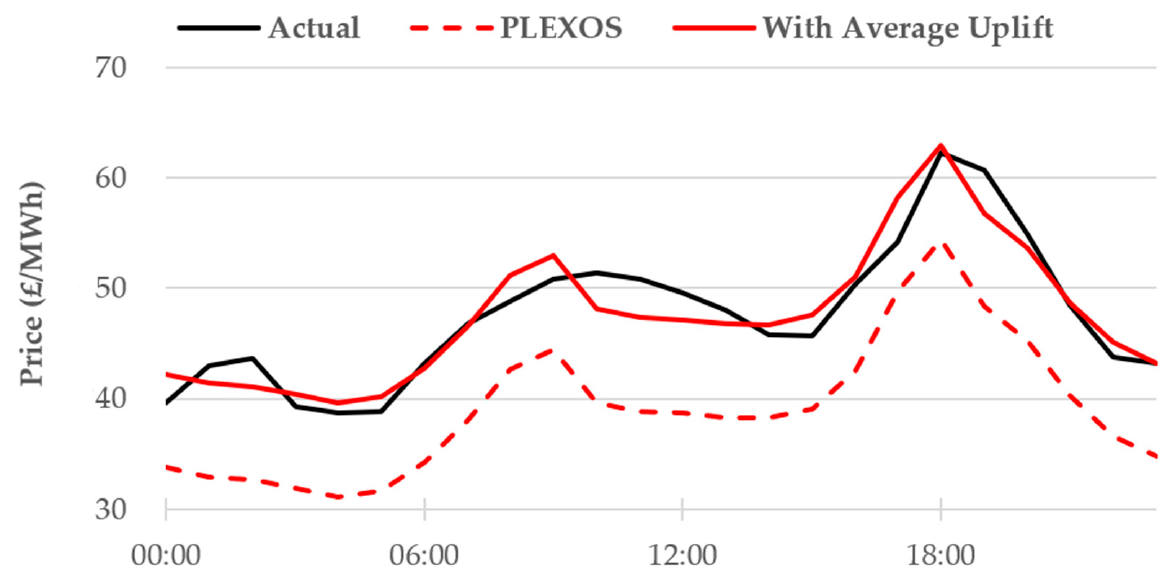
Figure 6. Hourly average electricity prices. The costs of generation do not include an uplift for long run marginal costs, so this is shown as the solid green line.